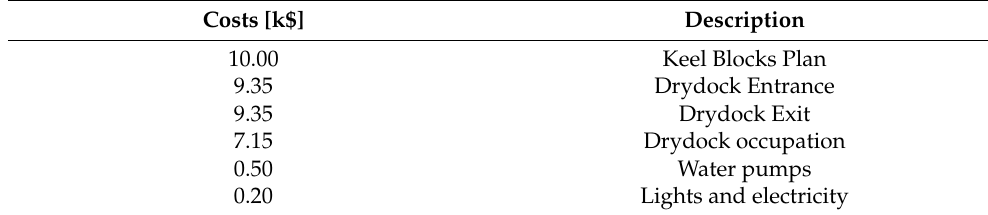
Table 4. Drydock cost for the installation of the